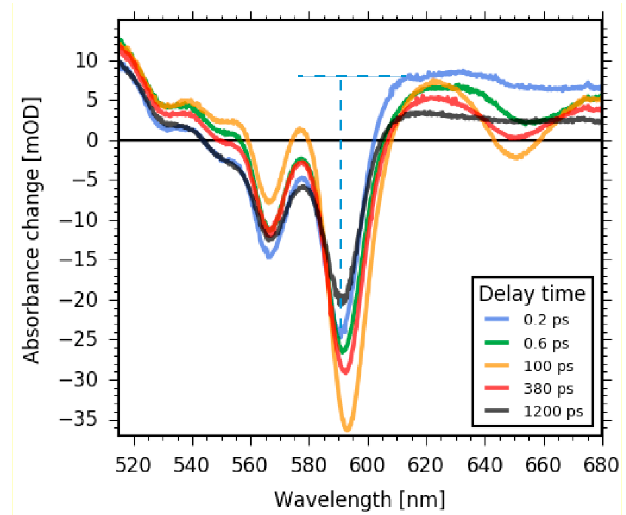
Figure 6. Selected absorbance difference spectra displaying the rise and decay of Q band stimulated emission (SE) signals as well as the change in excited state absorption (ESA). Over short time scales, the formation of SE at 650 nm is clearly visible. Longer delay times show the decay of SE at 650 nm and the decay of ESA around 550 nm. At early delay times (0.2 ps, blue line), the height of the Soret band ESA at 590 nm can be estimated by way of the blue dashed horizontal line and the signal strength of the initial bleaching signal at 590 nm by way of the blue dashed vertical line to be about 32 mOD. Around 100 ps after excitation, the positive signal at wavelengths between 520 nm and 685 nm due to the Q band ESA starts to decrease, accompanied by a decrease in the negative SE signal at 596 nm and 650 nm. These changes indicate a loss of SE and depopulation of the S 1 state. Since the bleaching signals at 565 nm and 590 nm do not recover (see Figure 6) and the SE contribution at 650 nm vanishes completely, we assign this process to intersystem crossing and triplet formation.